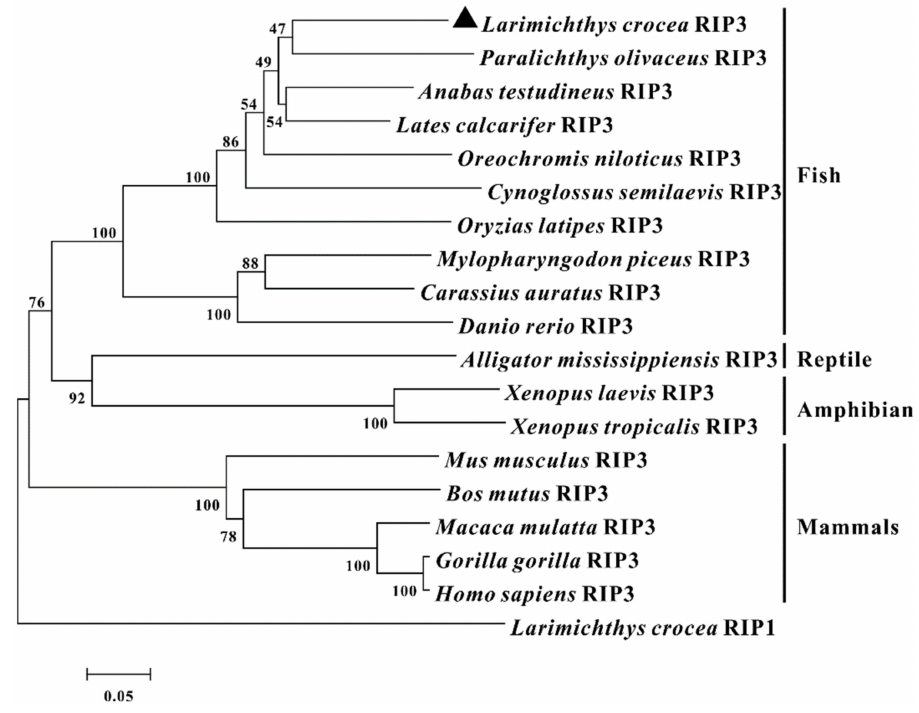
Figure 2. Phylogenetic analysis of vertebrate RIP3. The phylogenetic tree was constructed according to the alignment of amino acid sequences using the neighbor-joining method by MEGA 7.0 software with 10,000 replications in the bootstrap test. The GenBank accession numbers for the amino acid sequences used are as follows: L. crocea RIP3 (MZ574078), P. olivaceus RIP3 (XP_019967771.1), A. testudineus RIP3 (XP_026208769.1), Lates calcarifer RIP3 (XP_018543261.1), C. semilaevis RIP3 (XP_008316289.1), Oreochromis niloticus RIP3 (XP_003458818.2), O. latipes RIP3 (XP_023821938.1), M. piceus RIP3 (QXJ87326.1), Carassius auratus RIP3 (XP_026122240.1), D. rerio RIP3 (XP_001343827.1), Alligator mississippiensis RIP3 (XP_019343266.1), Xenopus laevis RIP3 (XP_018086823.1), X. tropicalis RIP3 (XP_002937800.1), M. musculus RIP3 (NP_064339.2), Bos mutus RIP3 (XP_014338619.1), Macaca mulatta RIP3 (XP_001114079.1), Gorilla gorilla RIP3 (XP_004055062.1), H. sapiens RIP3 (NP_006862.2), and L. crocea RIP1